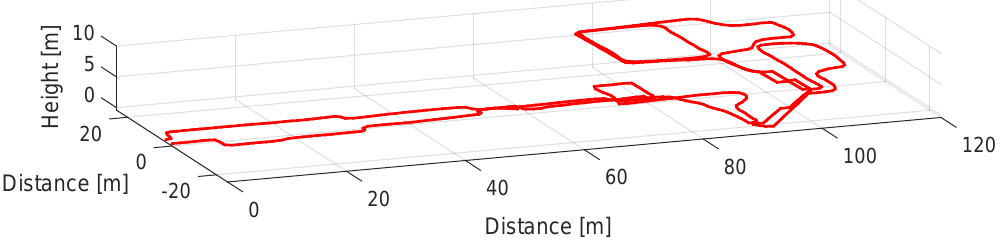
Figure 15. 3D trajectory drift compensated with (cid:101) o equals to − 0.068 ◦ · s − 1